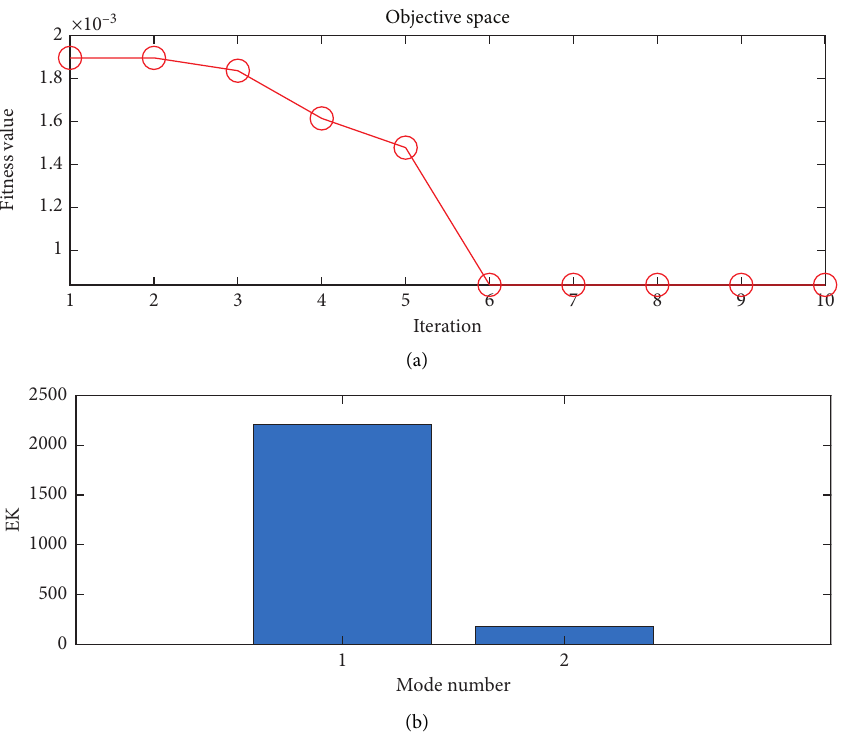
Figure 15: Simulated signals of case 2: the optimization process based on PAVMD: (a) PSO convergence curve and (b) the EK value of each